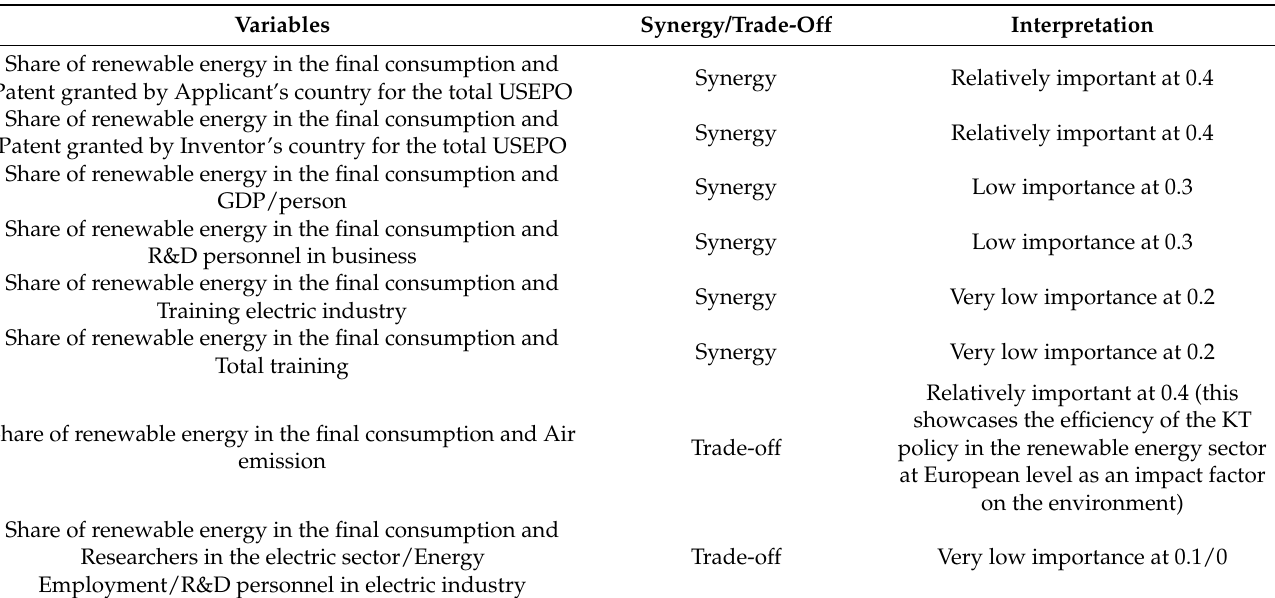
Table 6. Results of bi-dimensional